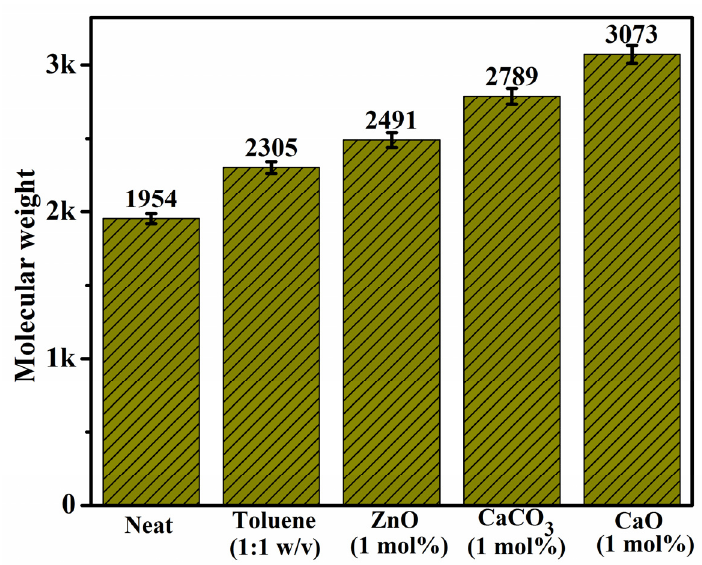
Figure 5. Weight average molecular weights of poly(sebacic acid) using different catalysts, analyzed by GPC. Sebacic acid was polymerized by heating with 0.3 equivalents of acetic anhydride along with 1% w / w catalyst powder and no solvents. Polyanhydrides synthesized in triplicate at 160 °C under vacuum (~10 m bar) for 4 h.